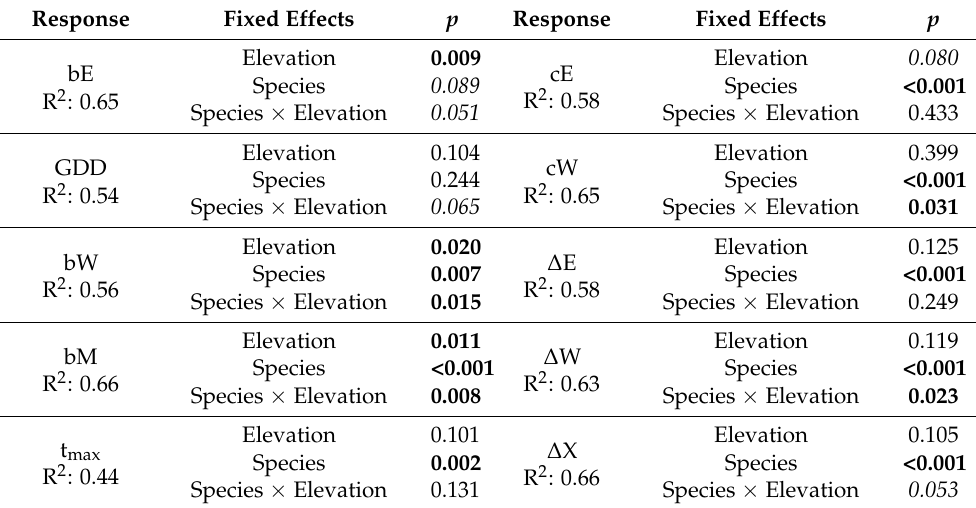
Table 3. p -values of ANOVAs based on linear mixed-effects models (LMMs) with xylem phenology and growing degree day (GDD) as response variables, tree species and elevation as fixed main and interaction effects and plot as random